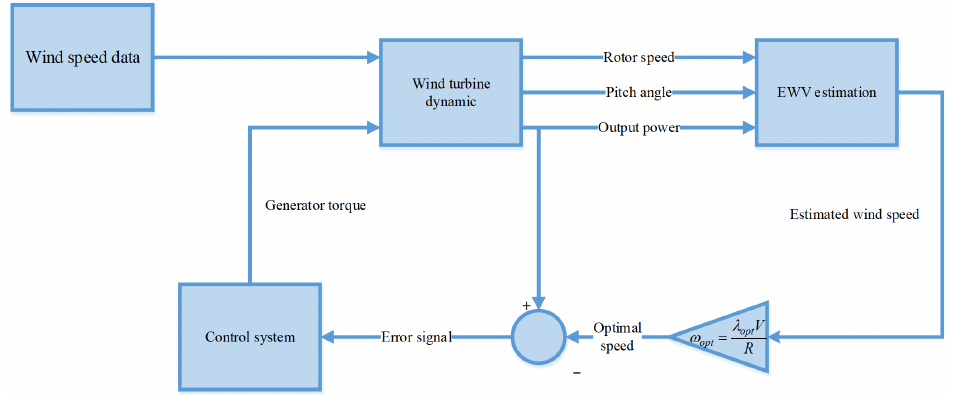
Figure 9. Schematic of the designed control system in region II.